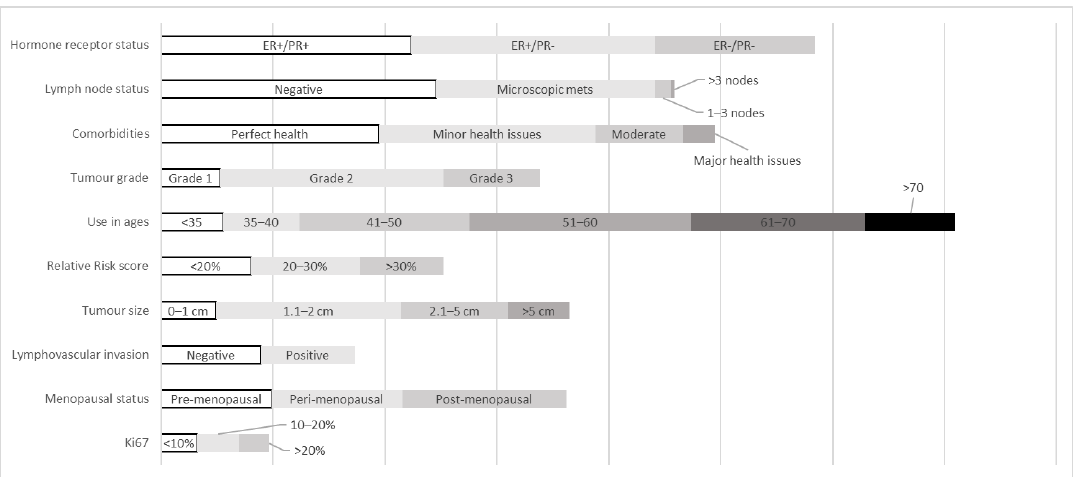
Figure 2. The frequency of ODX utilization for different clinicopathologic factors. The data has been transformed by applying an exponential weighting factor to better visualize which factors have the greatest importance to the respondents.